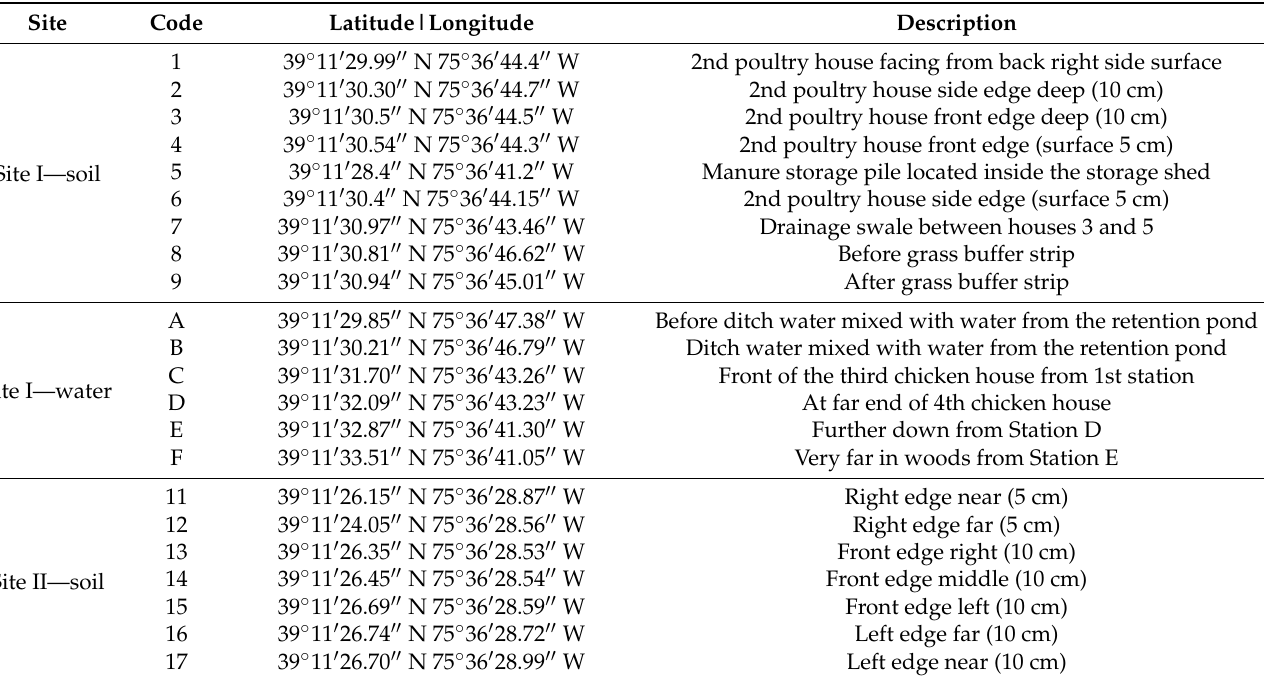
Table 1. Sampling site locations and descriptions in a poultry farm, Kent County, Delaware, USA.